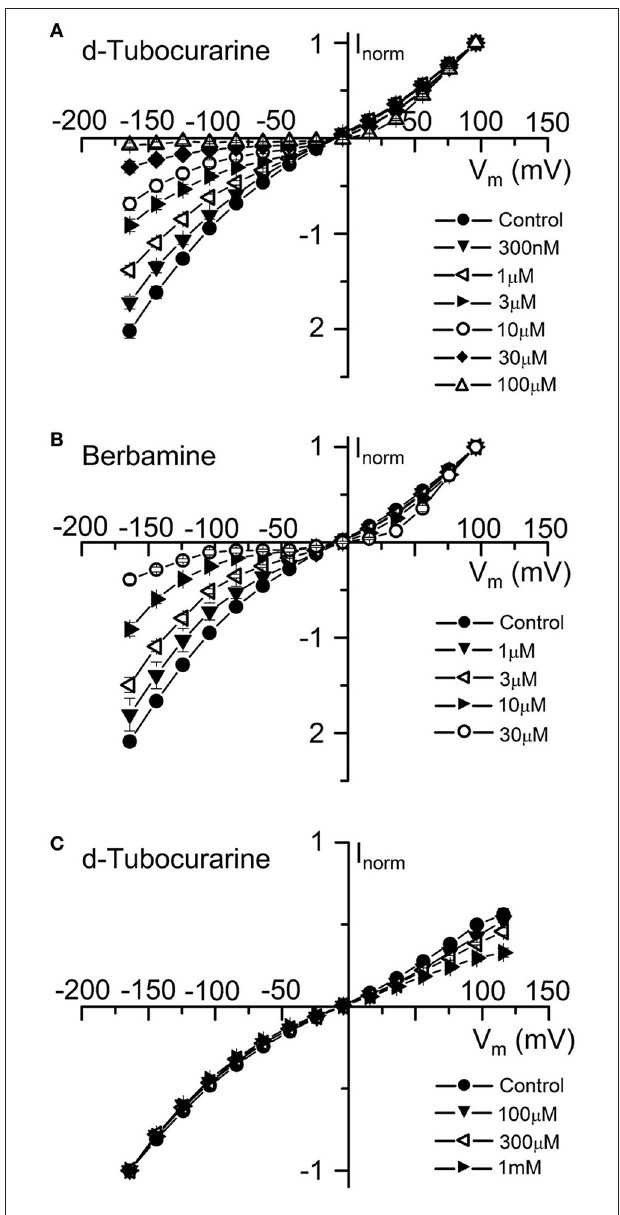
FIGURE 6 | Normalized current-voltage curves reveal the voltage-dependence of d-tubocurarine and berbamine MET channel block. (A,B) Average normalized current-voltage curves for the peak MET currents recorded before and during extracellular superfusion with 300 nM to 100 µ M dTC (A) , or 1 to 30 µ M extracellular berbamine (B) . Currents were normalized to the peak current measured at + 96 mV. For the two compounds, block increases with both increasing hyperpolarization and compound concentration. Inclusion of 0.1 to 1 mM dTC in the patch-pipette resulted in a block of the MET currents from the intracellular side at depolarized potentials (C) . Currents in (C) were normalized to the peak current measured at − 164 mV. Numbers of cells and peak current (A) Control: 43, 0.92 ± 0.05 nA; 300 nM: 5, 1.01 ± 0.14 nA; 1 µ M: 6, 1.00 ± 0.09 nA; 3 µ M: 9, 0.89 ± 0.10 nA; 10 µ M: 5, 0.75 ± 0.09 nA; 30 µ M: 13, 0.78 ± 0.10 nA; 100 µ M: 5, 0.32 ± 0.03 nA (B) Control: 37, 0.65 ± 0.07 nA; 1 µ M: 6, 0.76 ± 0.19 nA; 3 µ M: 14, 0.51 ± 0.10 nA; 10 µ M: 8, 0.54 ± 0.11 nA; 30 µ M: 9, 0.38 ± 0.11 nA (C) Control: 10, − 1.86 ± 0.13 nA; 100 µ M: 3, − 1.84 ± 0.31 nA; 300 µ M: 2, − 1.95 ± 0.12 nA; 1 mM: 5, − 1.40 ± 0.13 nA.